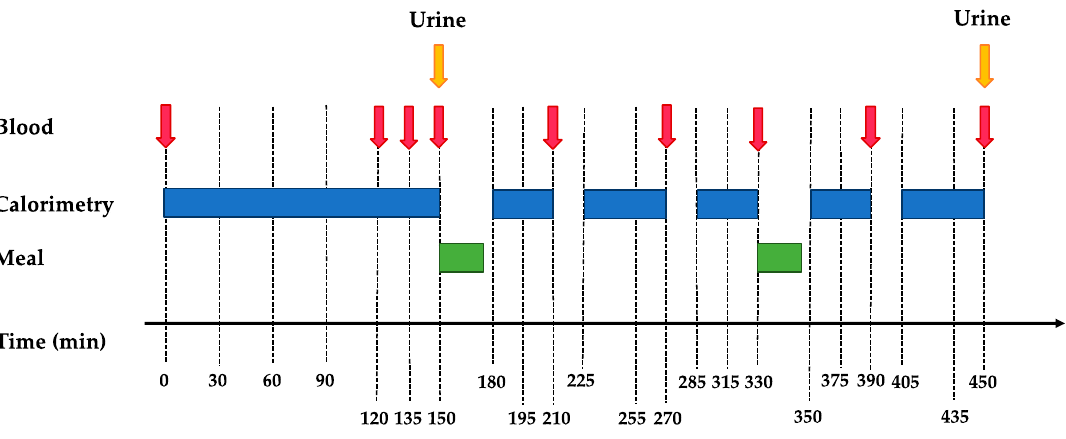
Figure 2. Schema of metabolic tests at D0 and D7.